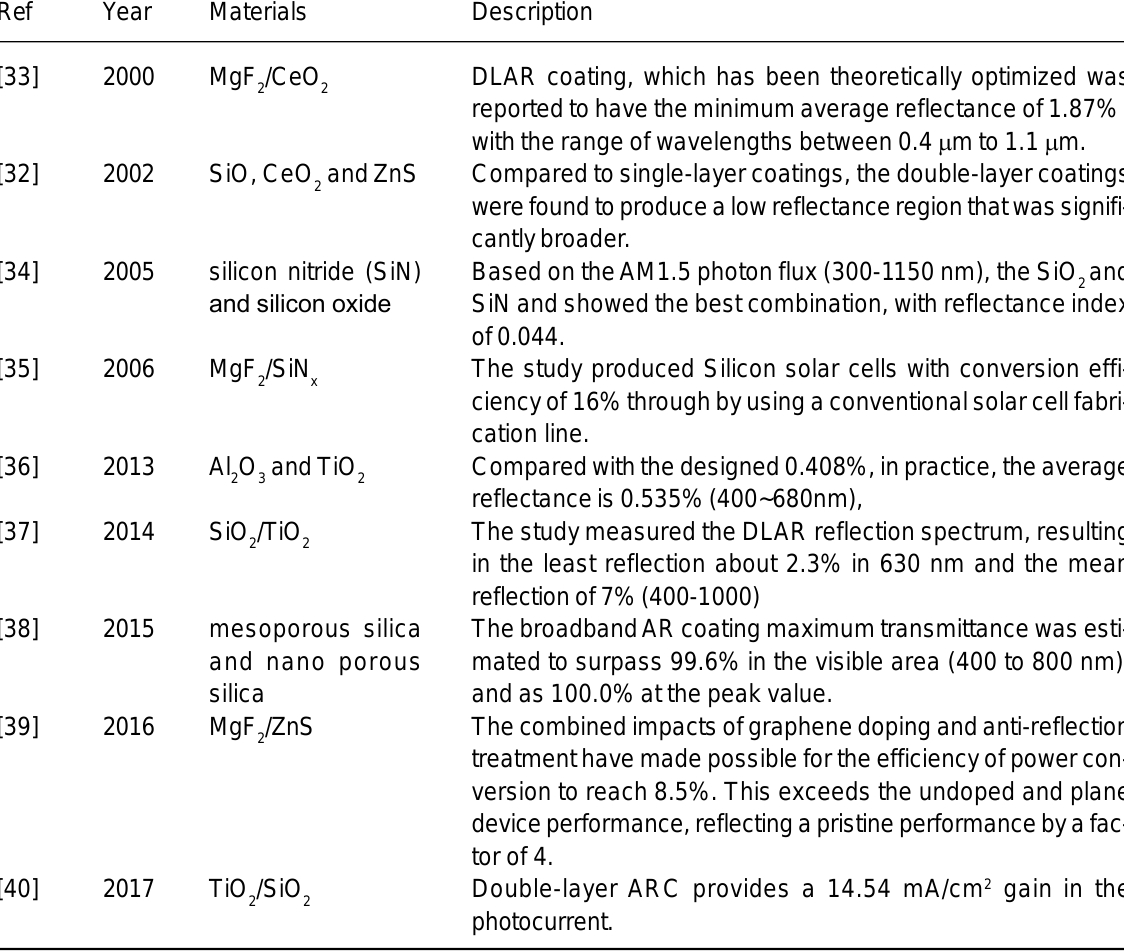
Table 1. Some research discoveries pertaining to various double layer ARCs.